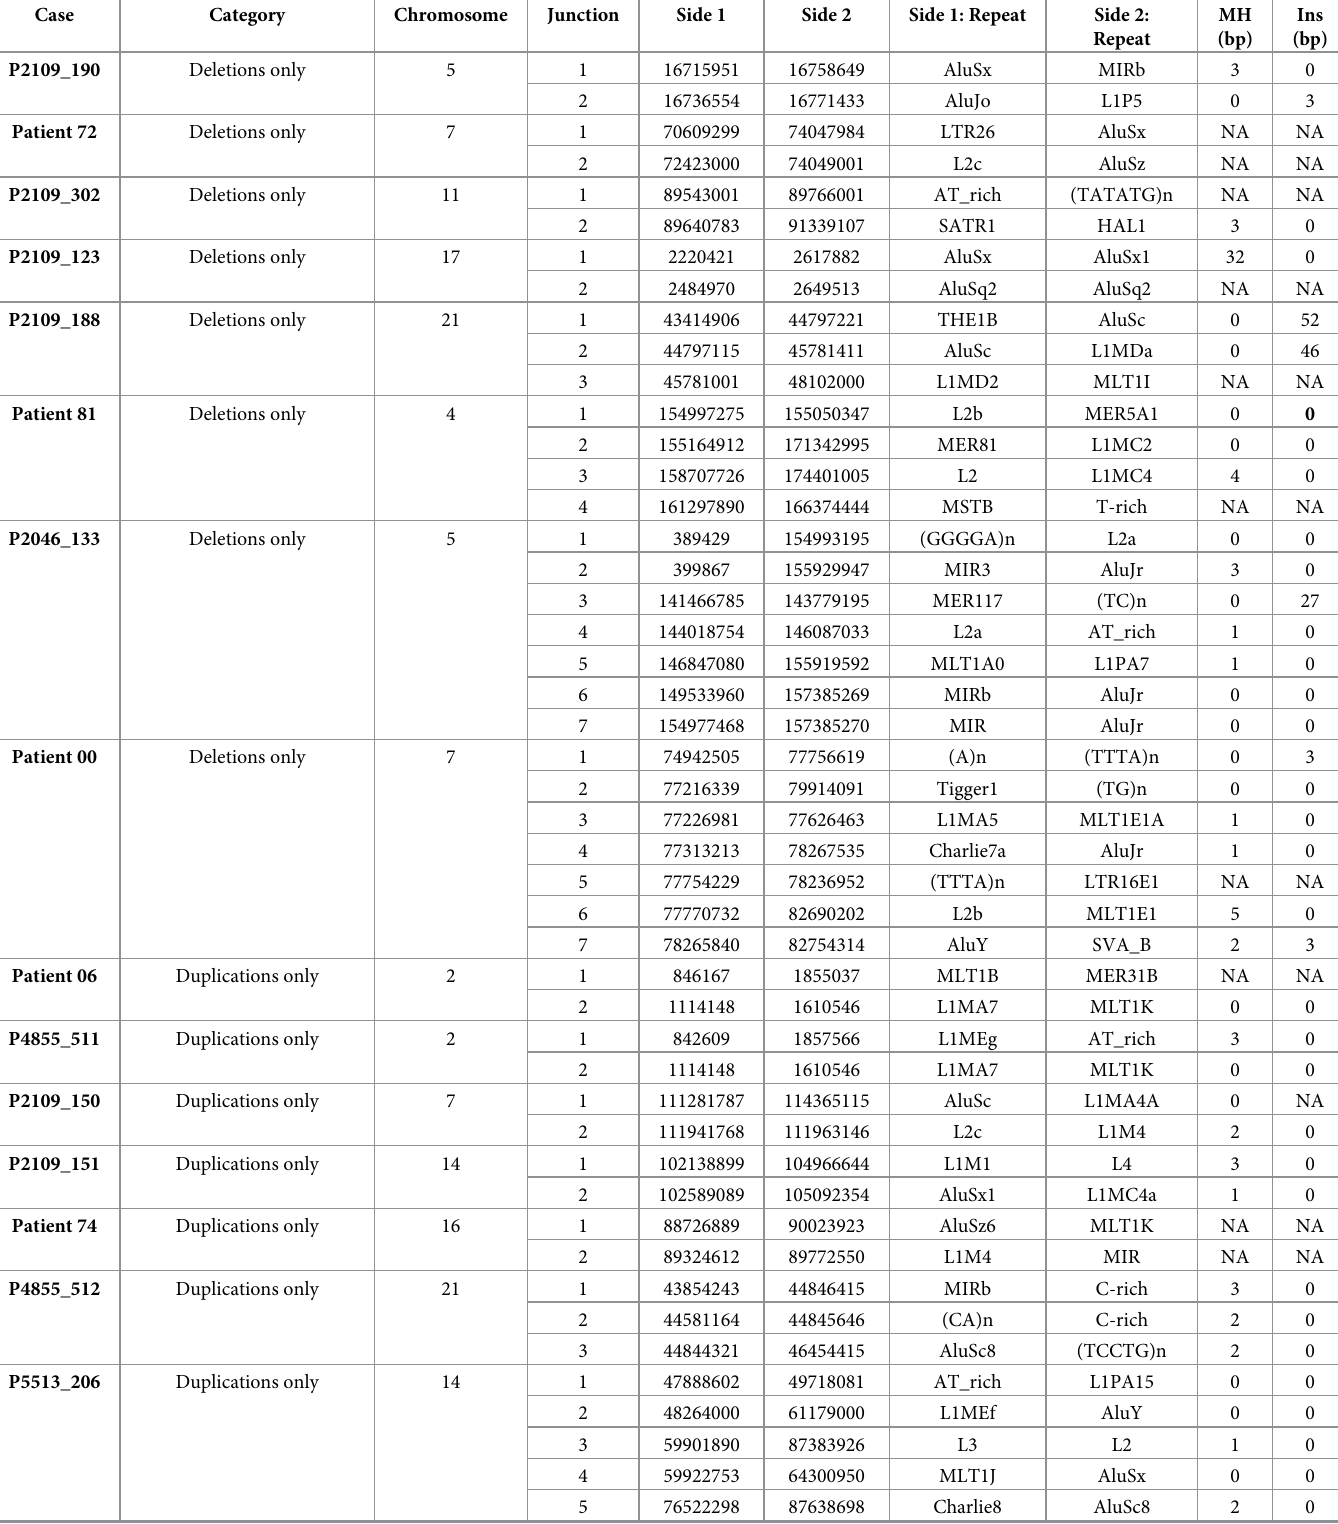
Table 2. Characteristics of all breakpoint junctions that were solved on single nucleotide